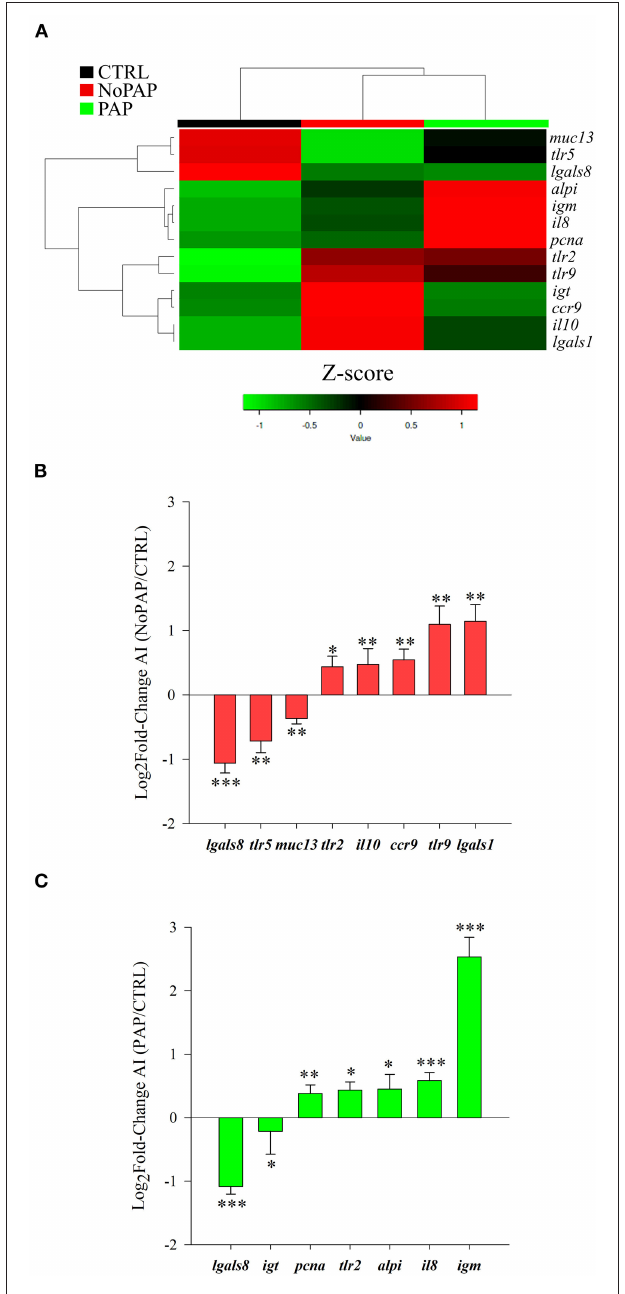
FIGURE 5 | Differentially expressed (DE) genes in the anterior intestine of fish fed with the experimental diets when compared with those fed with the CTRL diet ( P < 0.05). (A) Heatmap depicting the relative expression of the DEGs in the three dietary groups. Log 2 fold changes of differentially expressed genes ( + SEM) in comparisons (B) non-PAP vs. CTRL and (C) PAP vs. CTRL are shown [asterisks represent statistically significant differences at * P <